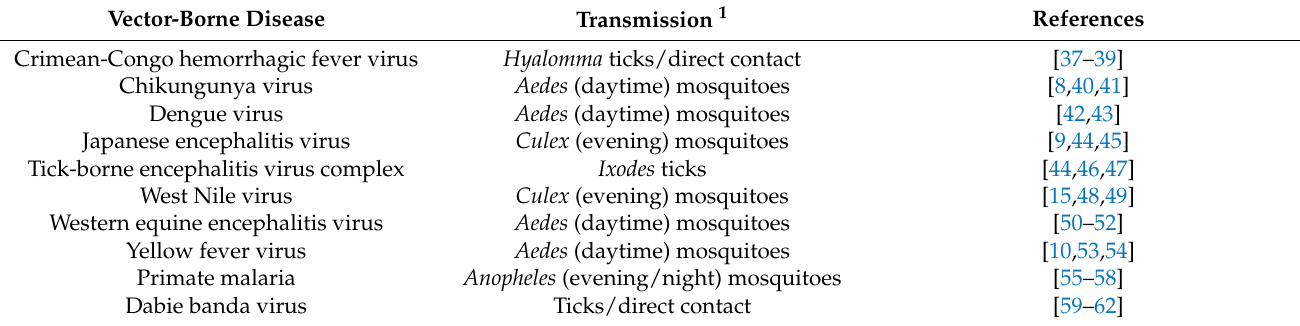
Table 1. Vector-borne diseases considered as having the potential to spread to humans in and around wet and wildlife markets. Direct contact indicates the disease can also spread directly to humans by contact with blood or other bodily fluids, in addition to through a